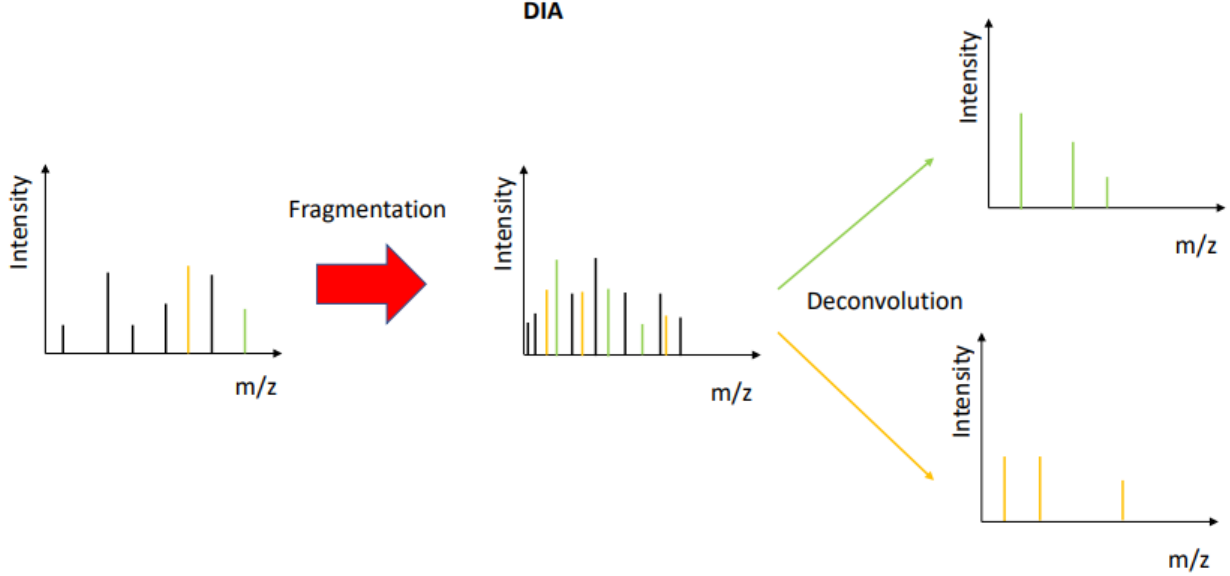
Figure 5. Schematic of SWATH-MS fragmentation of two compounds (green and yellow). Guo et al. performed a comparison of acquisition modes using full-scan, DDA and DIA in all-ion fragmentation and SWATH modes by employing the different modes on a urine sample [52]. The authors assessed the different modes with five different criteria: number of features, convenience, quantitative precision, MS/MS spectral quality and MS/MS spectral coverage. In terms of the number of features, full-scan mode performed best, which is not surprising, because all of the acquisition time is used for feature eluci- dation and, therefore, most of the features are detected. Hence, the use of full-scan mode leads to limited information in untargeted screening, which makes annotation of un- knowns exceedingly difficult, because only retention time and precursor mass can be used